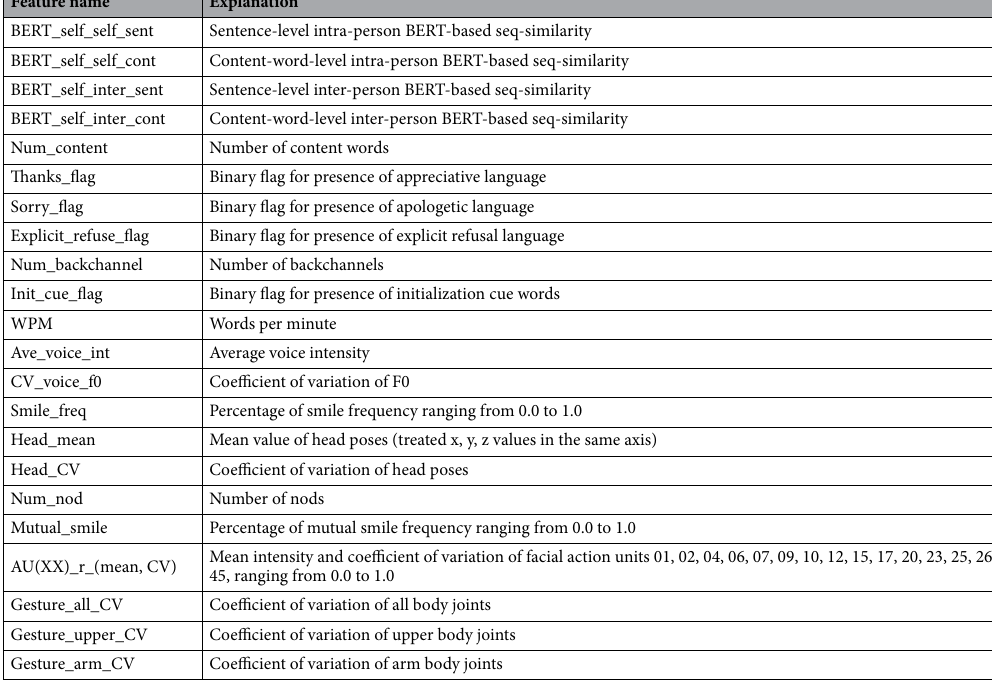
Table 2. Input features used for our automated evaluation